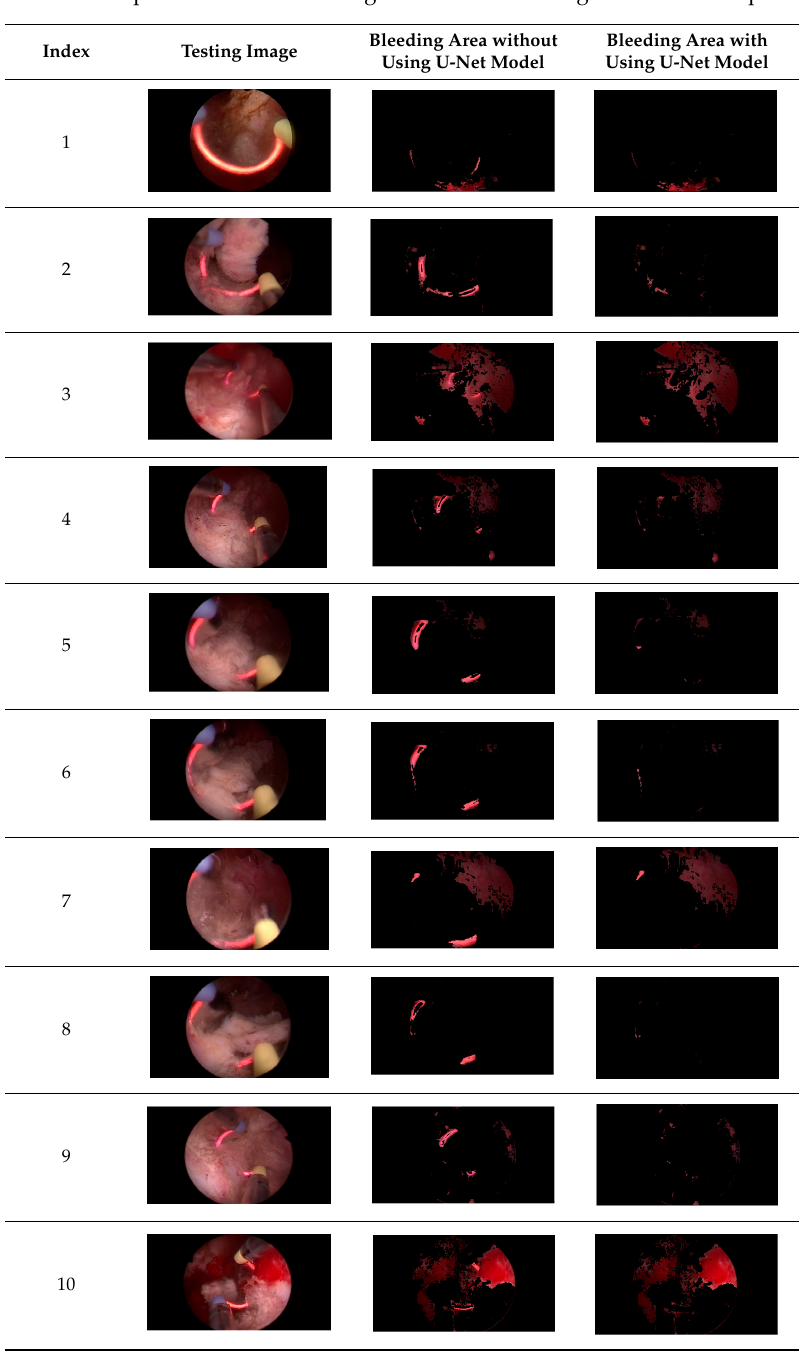
Table 9. The performance of bleeding area extraction using the HSV color space.